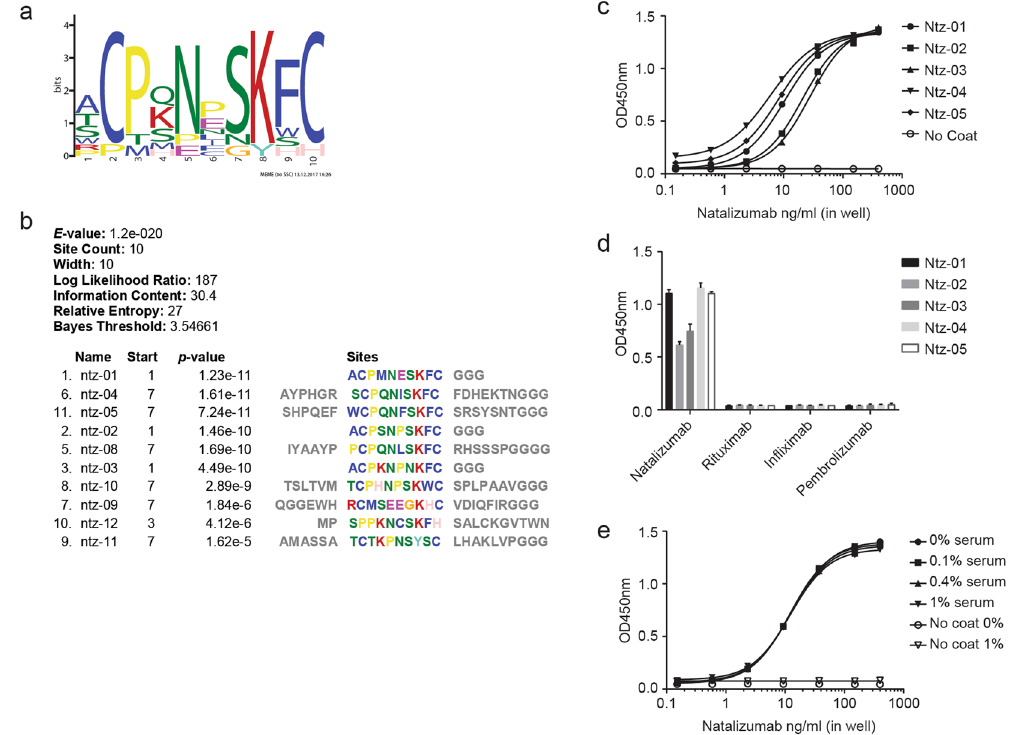
Figure 1. Natalizumab biopanning results and performance of selected peptides in ELISA ( a ) Consensus motif of selected peptide sequences from phage display panning. ( b ) Sequence alignment of motif-containing peptide sequences. ( c ) Natalizumab capture by immobilized synthetic peptides in ELISA. EC50 (ng/ml in well) of calibration curves: Ntz-01: 13.95, Ntz-02: 37.88, Ntz-03: 51.68, Ntz-04: 6.7, Ntz-05: 10.45. ( d ) Selectivity of synthetic peptides against control therapeutic mAbs in ELISA. ( e ) Ntz-01 capture of natalizumab spiked into 0.1–1% human serum. For ( c–e ), one representative experiment is shown, with error bars representing SD of duplicate wells.